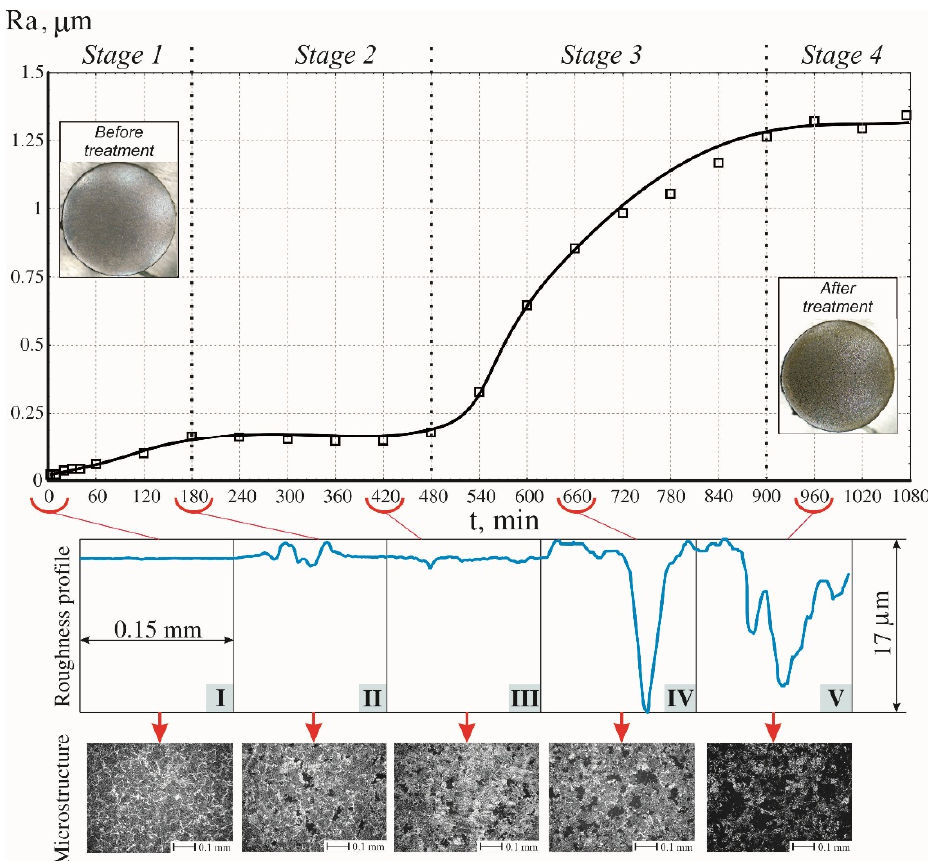
Figure 6. Dynamics of changes in the roughness parameter, Ra, for 45